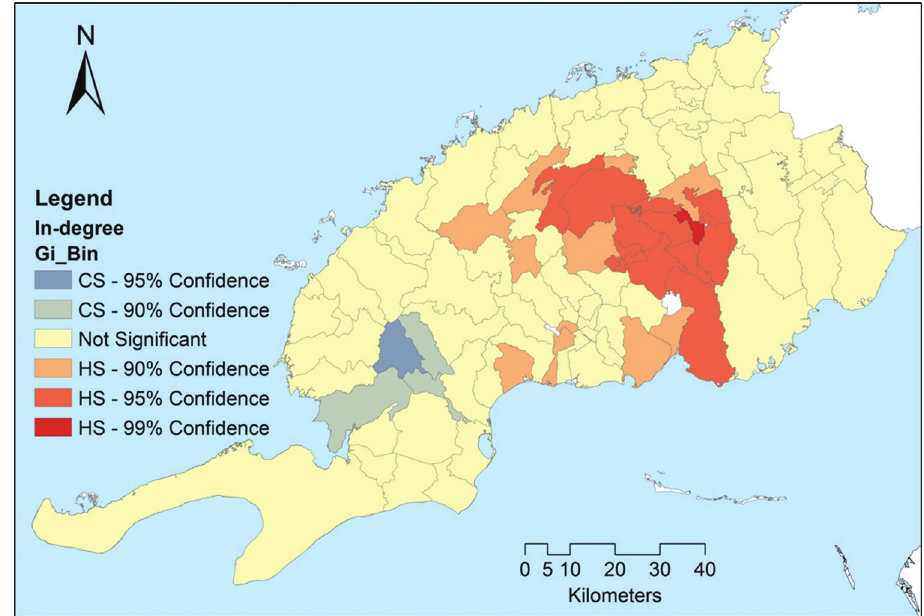
Figure-2: High and low swine in-degree spatial clusters (CS – Cold spot and HS – Hot